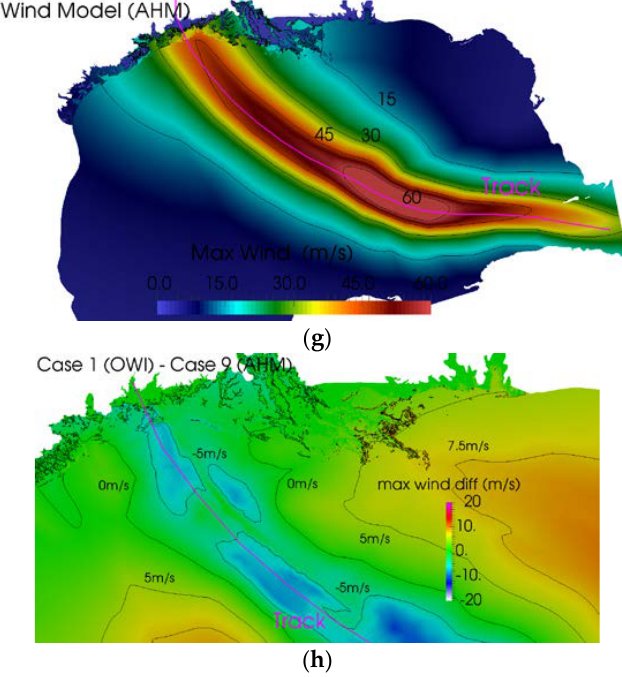
Figure 8. Rita maximum wind track plots (i.e., ‘max wind’) and difference of wind speed between OWI and other wind models (i.e., ‘max wind diff’) ( a and b ) Case 6; ( c and d ) Case 7; ( e and f ) Case 8; ( g and h ) Case 9.